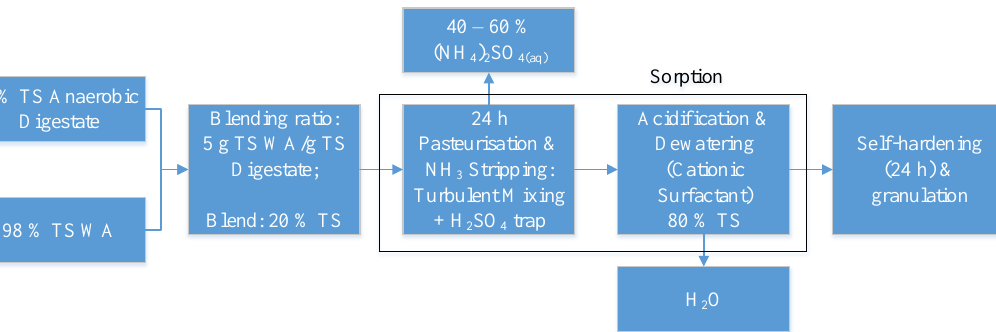
Figure 4. Schematic block flow diagram of the proposed downstream processing of the anaerobic digestate with WA to produce a granular organic fertilizer (%TS = percentage of total solids). Elaborated considering the different treatments, synergies, and technologies that can be implemented with a blend of WA and anaerobic digestate